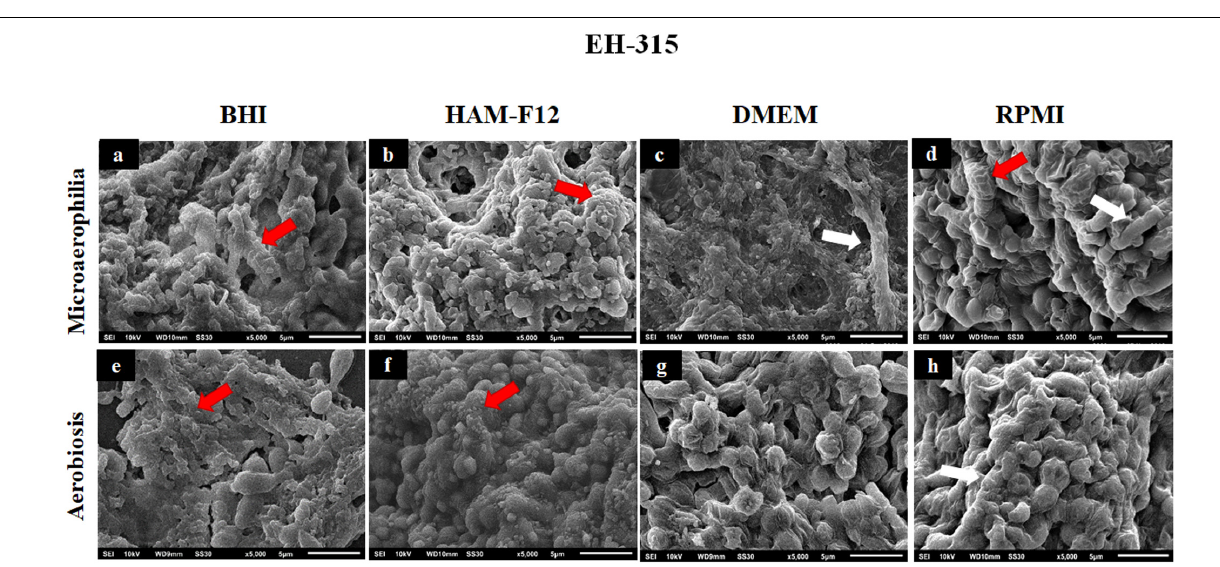
Frontiers in Microbiology |